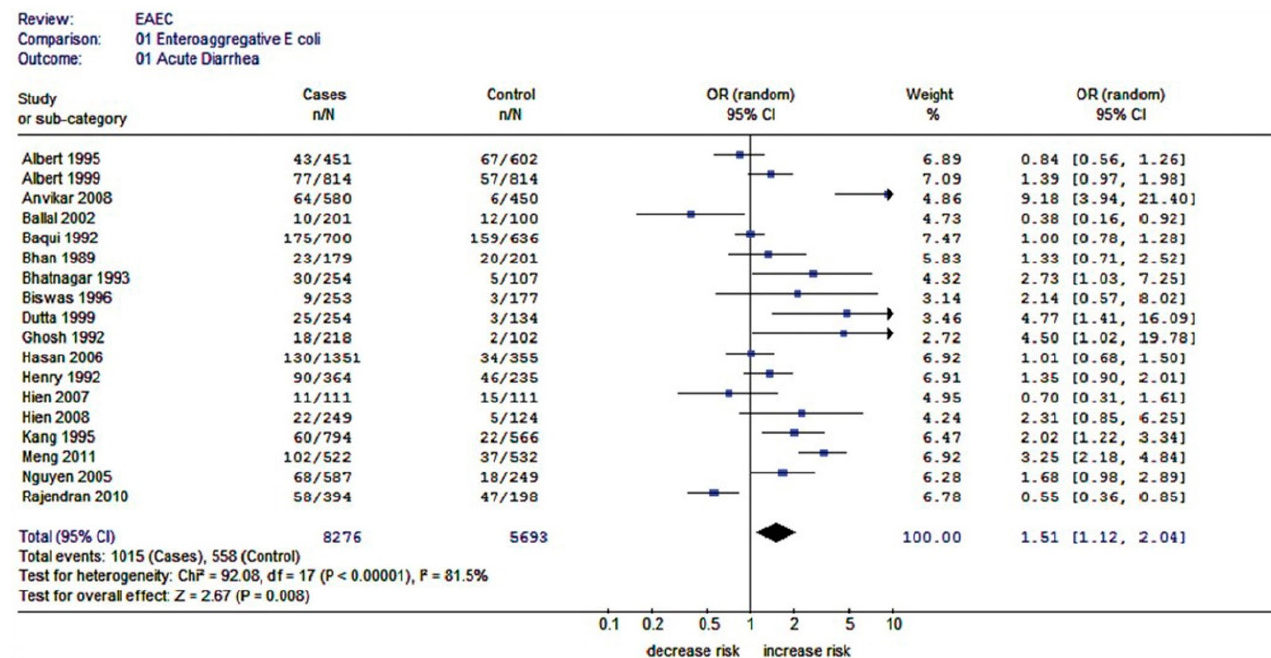
Figure 6. Illustrative image of forest plot generated by RevMan [94].